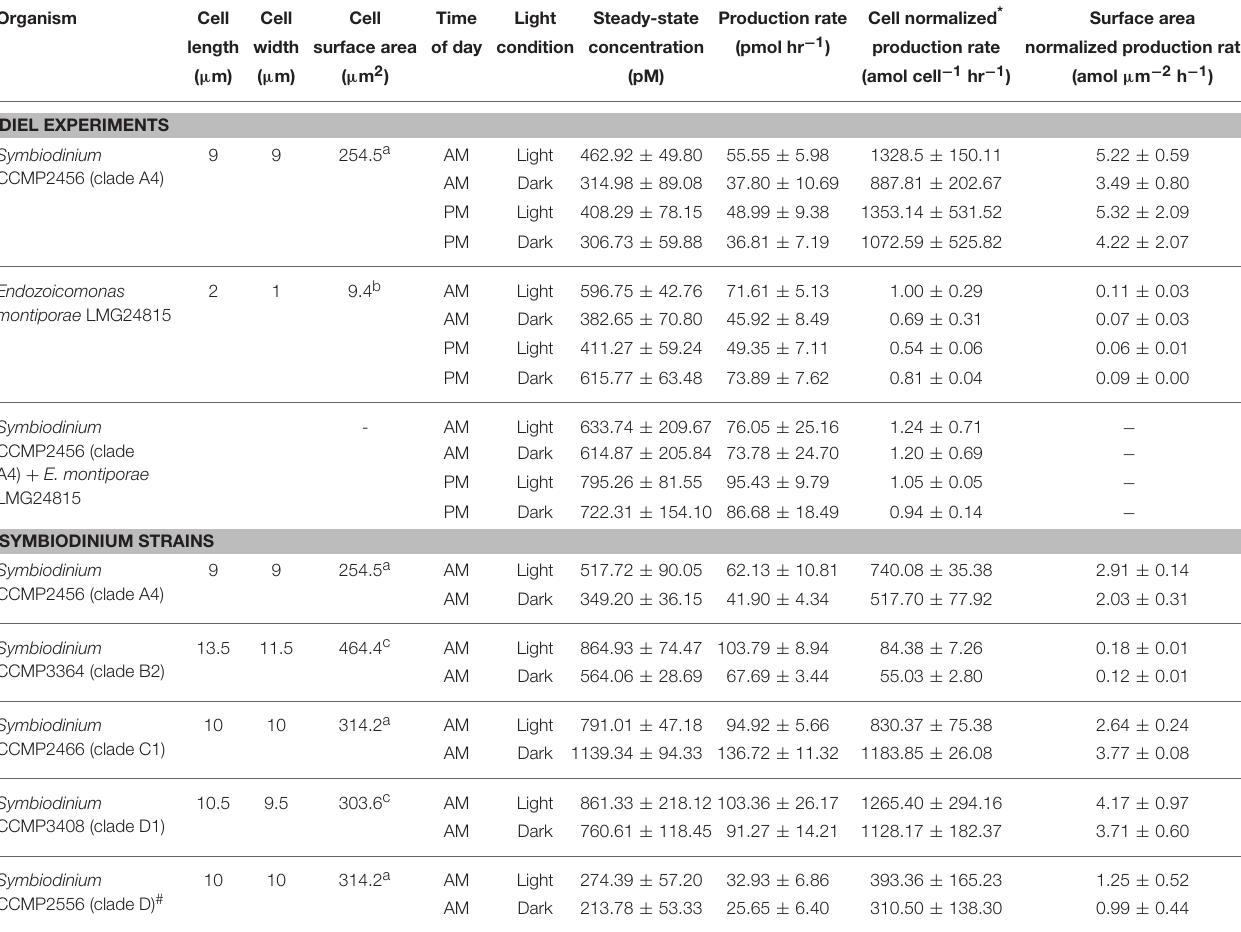
TABLE 4 | Summary of superoxide measurements as the mean ± SEM for biological replicates ( n = 3) analyzed during mid-exponential growth. Organism Cell Cell Cell Time Light Steady-state Production rate Cell normalized * Surface area length width surface area of day condition